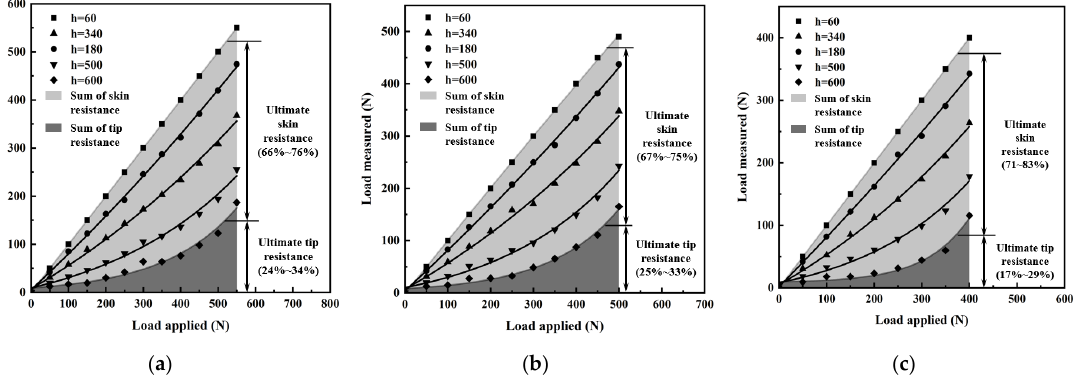
Figure 16. Variation curves of skin and tip resistance: ( a ) helix number test sets, ( b ) helix size test sets, and ( c ) drilling speed test sets.